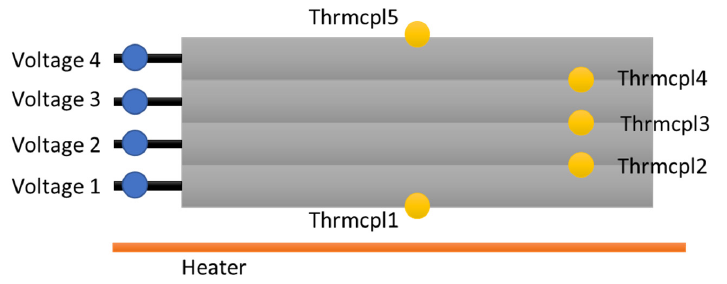
Figure 4. Description of sensors’ positioning for TR propagation experiment. Thermocouples